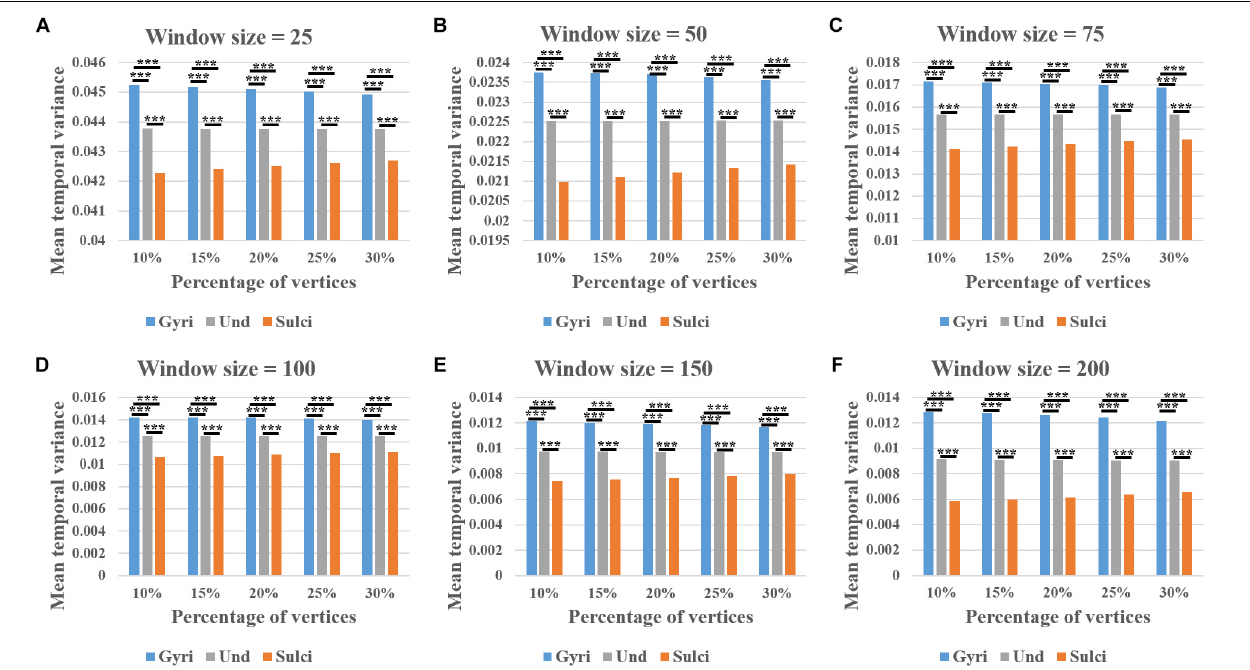
FIGURE 3 | Mean temporal variance difference of functional activity among gyri, sulci, and undefined regions across all brain regions in a single subject. (A–F) The mean temporal variance of gyri, sulci, and undefined regions when window size equals 25, 50, 75, 100, 150, and 200, respectively. Within each sub-figure, five convexity threshold values (10, 15, 20, 25, and 30) corresponding to five percentages of vertices (10, 15, 20, 25, and 30%) are tested. ∗∗∗ Indicates p < 0.001.